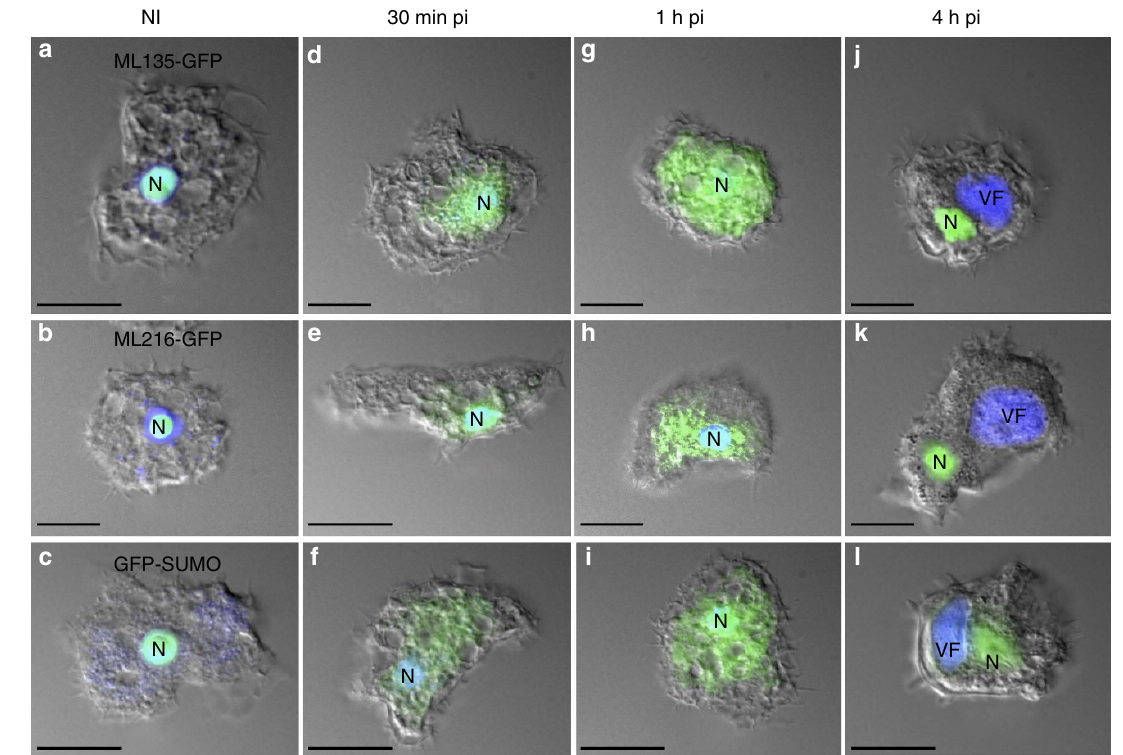
Figure 7 | Fluorescence study of A. castellanii cell nucleus during Noumeavirus infection. Fluorescence images (scale bar, 10 m m) of the nucleus (N) in non infected ( a ) and cells infected by Noumeavirus expressing the nuclear ML135-GFP at ( d ) 30min pi, ( g ) 1h pi and ( j ) 4h pi. Non-infected cells ( b ) and infected cells expressing the nucleolar ML216-GFP at ( e ) 30min pi, ( h ) 1h pi and ( k ) 4h pi. Non-infected cells ( c ) and infected cells expressing the nuclear GFP-SUMO at ( f ) 30min pi, ( i ) 1h pi and ( l ) 4h pi. DAPI staining remains at the nucleus all along the infection but the intense staining of the late VF makes it barely visible at the nucleus 4h pi ( j – l ). The GFP staining located in the nucleus of uninfected cells progressively spreads out of the nucleus ( d – f ) before filling the cytoplasm ( g – i ). After 4h, the GFP florescence is back into the nucleus and the DAPI staining is intense in the viral factories ( j – l ).